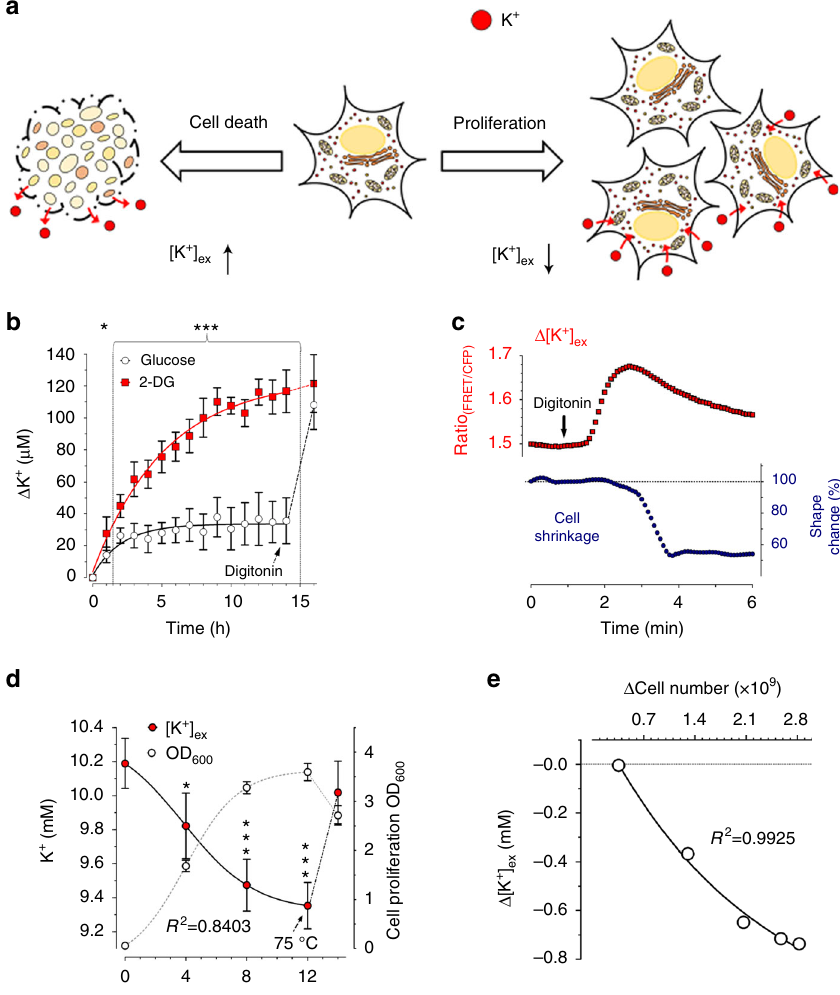
Fig. 3 Application of puri fi ed GEPII 1.0 to determine cell viability and cell growth. a Scheme demonstrating cellular K + loss upon cell death (left arrow) or K + uptake of proliferating cells (right arrow). b [K + ] over time determined with GEPII 1.0 within the supernatant of INS-1 cells cultured either in the presence of 10 mM glucose (white circles and black line, n = 6 ± SD) or 10 mM 2-deoxyglucose (red squares and line, n = 6 ± SD). As indicated, 50 µ M digitonin was applied after 14 h. * P = 0.0178, *** P < 0.0005, unpaired t -test. c Representative FRET ratio signals over time of recombinant GEPII 1.0 within the supernatant of HeLa cells (upper red curve) were recorded simultaneously with morphological alterations (cell shrinkage) of cells (lower blue curve) on an inverted fl uorescence microscope. As indicated, 30 µ M digitonin was added to induce cell necrosis. d [K + ] of cell culture medium over time determined with puri fi ed GEPII 1.0 (red circles, n = 5 ± SD, * P = 0.05, *** P < 0.005, one-way ANOVA test with Tukey ’ s Multiple Comparison Test) during bacterial ( E.